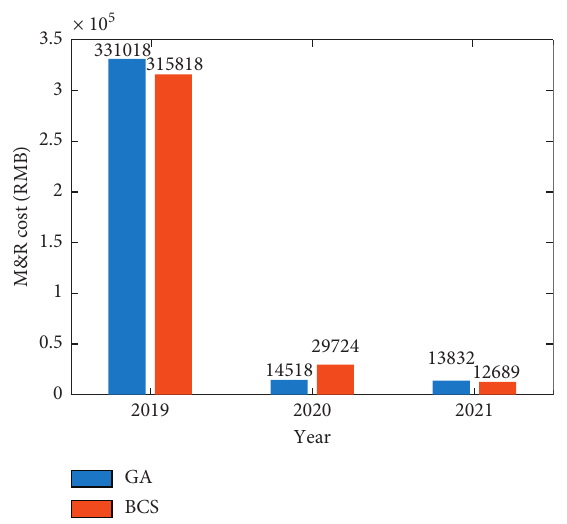
Figure 13: Budget allocation in each year under biobjective